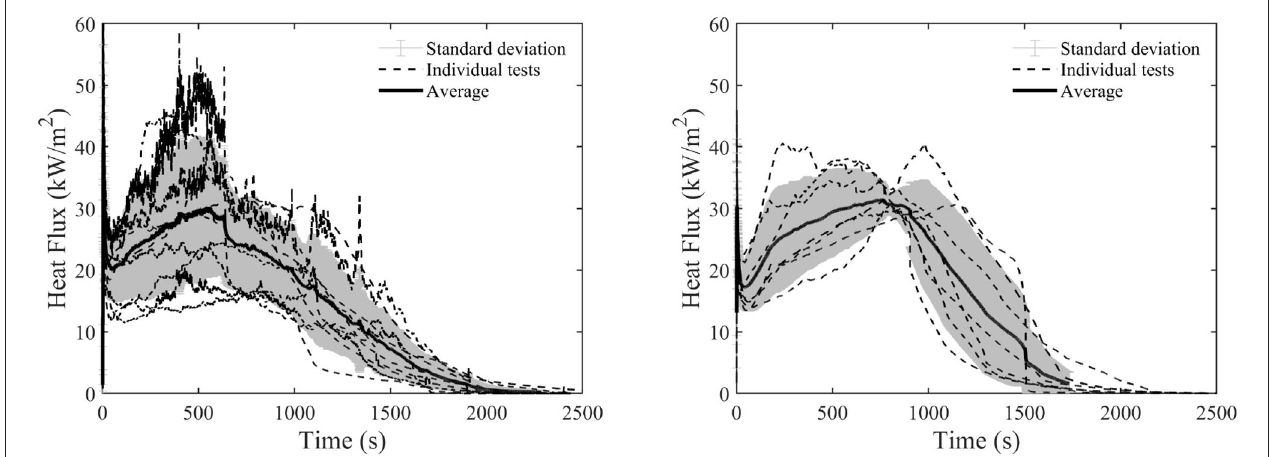
FIGURE 4 | Heat fluxes recorded from a WC-HFG are shown for 16 g of smoldering birch firebrands deposited over the sensor array for 1.2 m/s (left) and 1.4 m/s (right) . The shaded area represents the standard deviation between tests. Dashed lines represent all individual tests